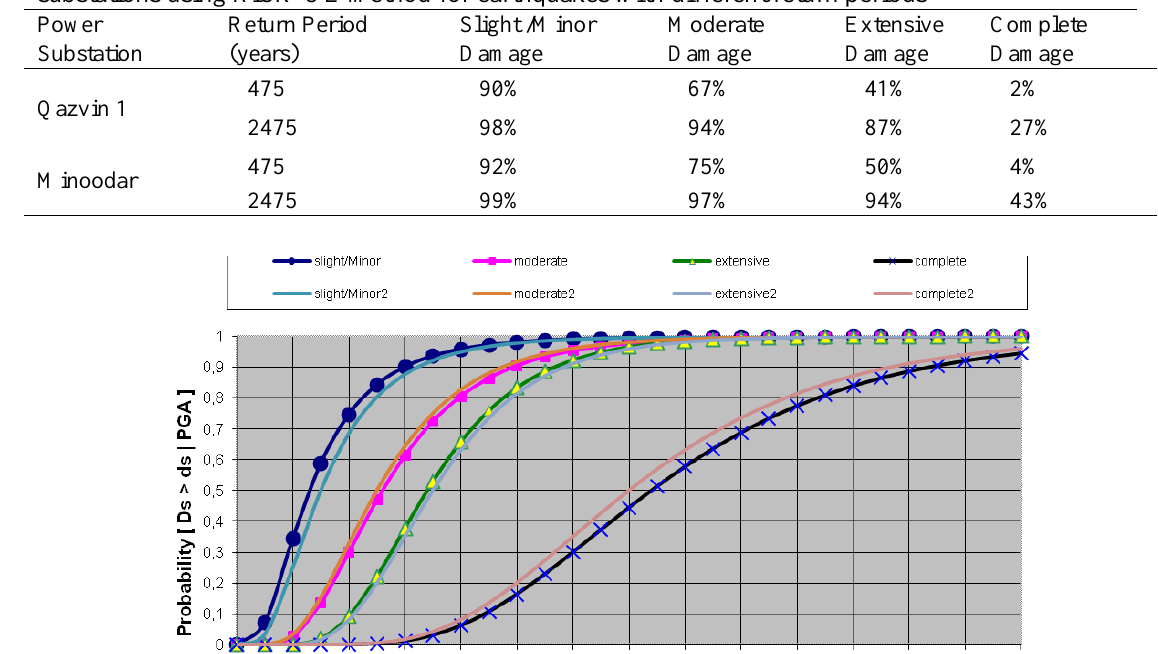
Figure12. RISK-UE fragility curve for low voltage power substations with unanchored components Table 11. Probability of exceeding from each damage state for Qazvin1 and Minoodar power substations using RISK-UE method for earthquakes with different return periods